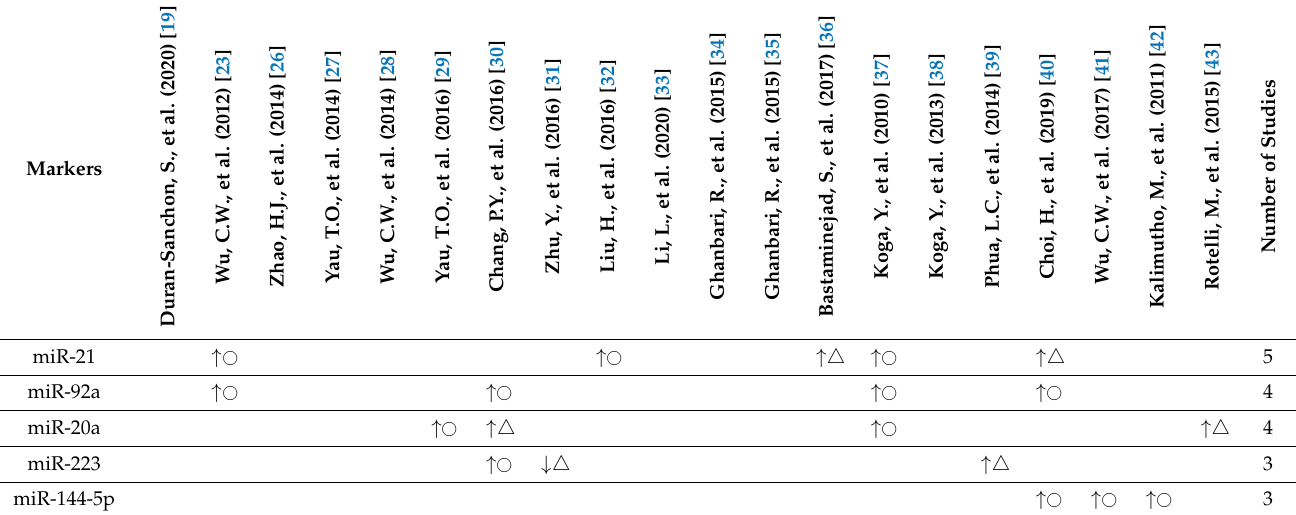
Table 5. Summary of studies reporting significant associations of miRNAs with CRC